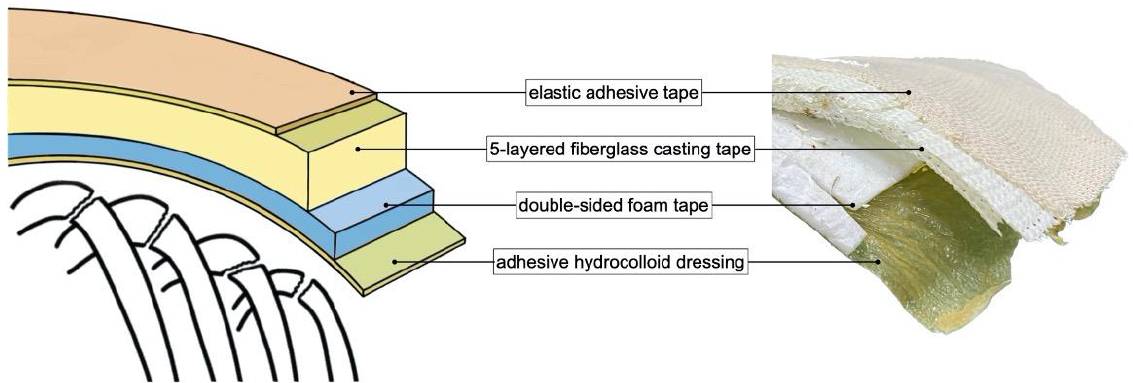
Figure 2. Cross-sectional view of a K-Rod. The four layers of the K-Rod are as follows: an innermost layer of adhesive hydrocolloid dressing, a layer of double-sided foam tape, a piece of five-layered fiberglass casting tape, and an outmost layer of elastic adhesive tape.